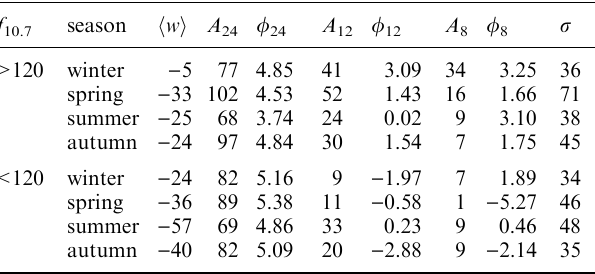
Table 7. Harmonic decomposition at 209 km